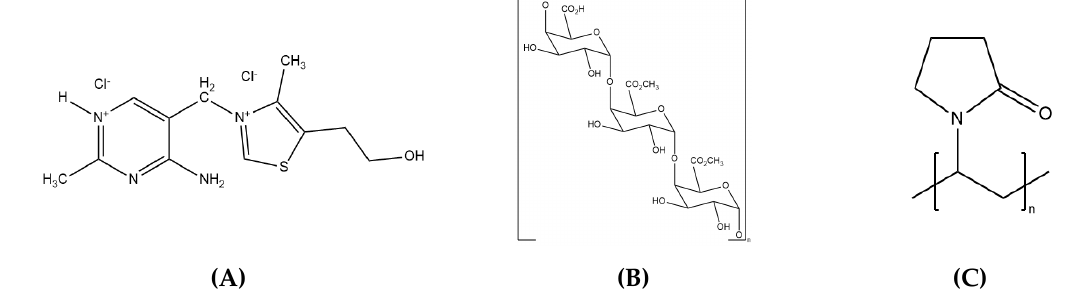
Figure 6. Chemical structures of ( A ) thiamine, ( B ) pectin, and ( C ) PVP.